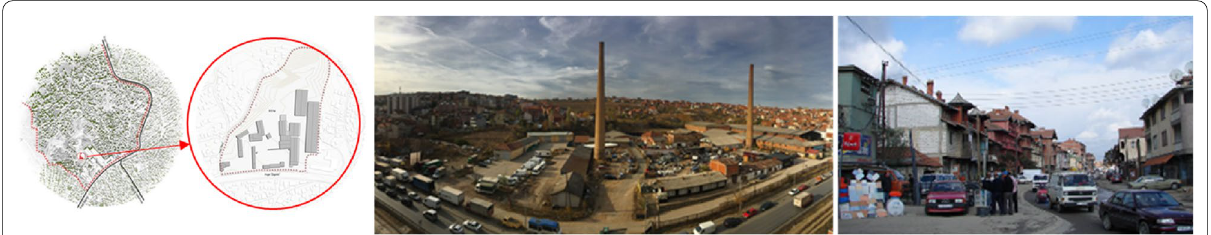
Fig. 2 Brick Factory: a location of the site, b bird perspective, c